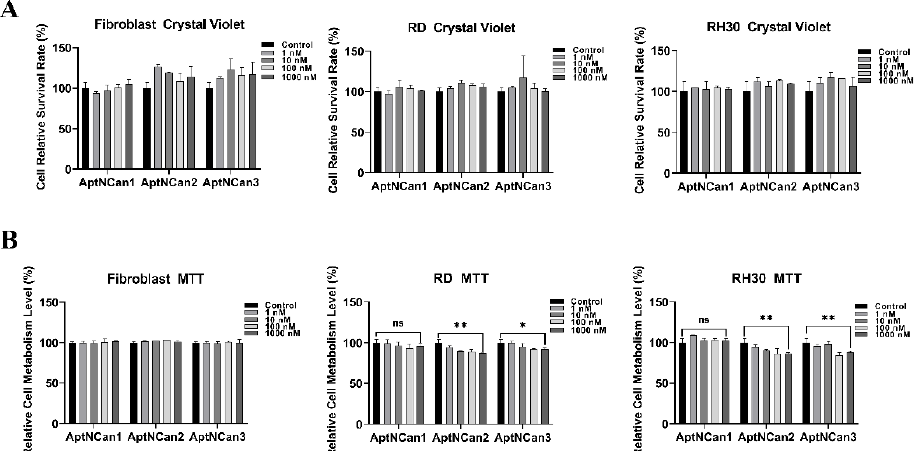
Figure 5. Measurement of potential effects of anti-NELL1 aptamers on cell proliferation. ( A ) Crystal violet assay results comparing the cell relative survival rate of fibroblast, RD, and RH30 sarcoma cells after treated with different concentrations of anti-NELL1 aptamer candidates for 24 h. ( n = 6) ( B ) MTT assay results comparing the cell relative metabolism level of fibroblast, RD, and RH30 sarcoma cells after treated with different concentrations of anti-NELL1 aptamer candidates for 24 h. ( n = 6) Data are presented as mean ± SD for each individual cell line ( n = 3). Significance was tested using a two-tailed t-test compared to the untreated cells for each cell line (* p ≤ 0.05 and ** p ≤ 0.01, ns = not significant).